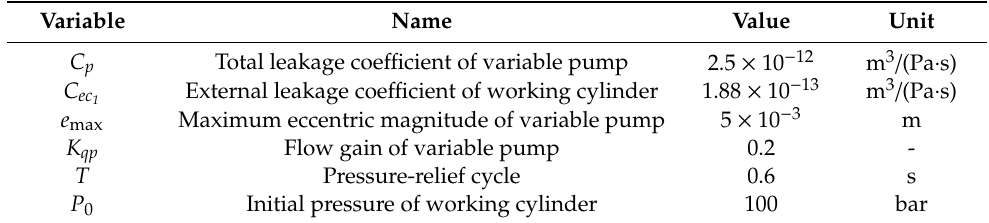
Table 2. The system parameters of the 0.6 MN forging press test-bed before the pressure relief under certain condition.